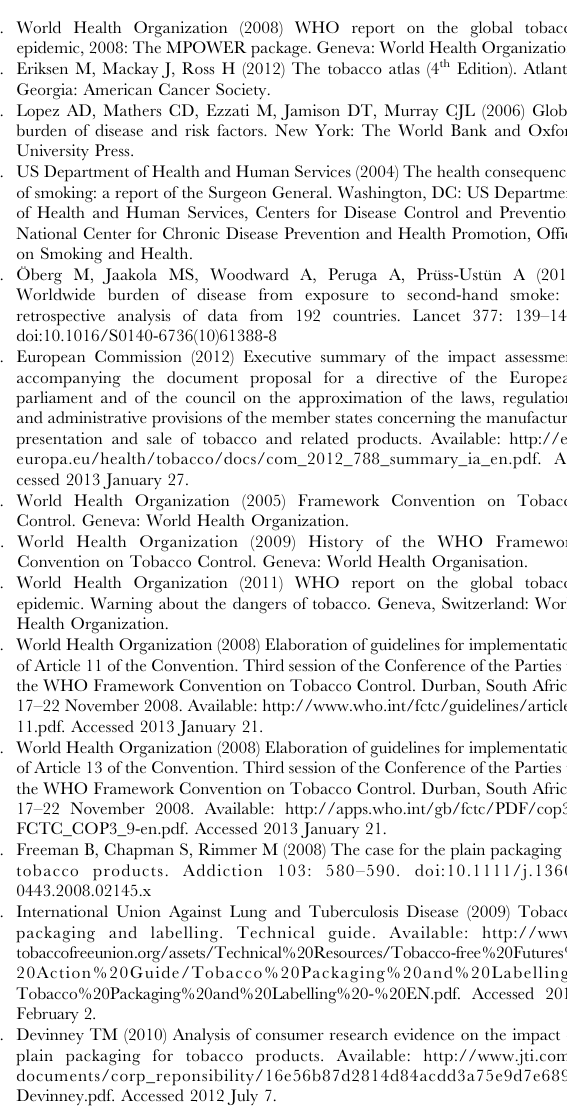
Table S1 Methodological characteristics and main findings of quantitative studies examining appeal, salience of health warnings and perceptions of product